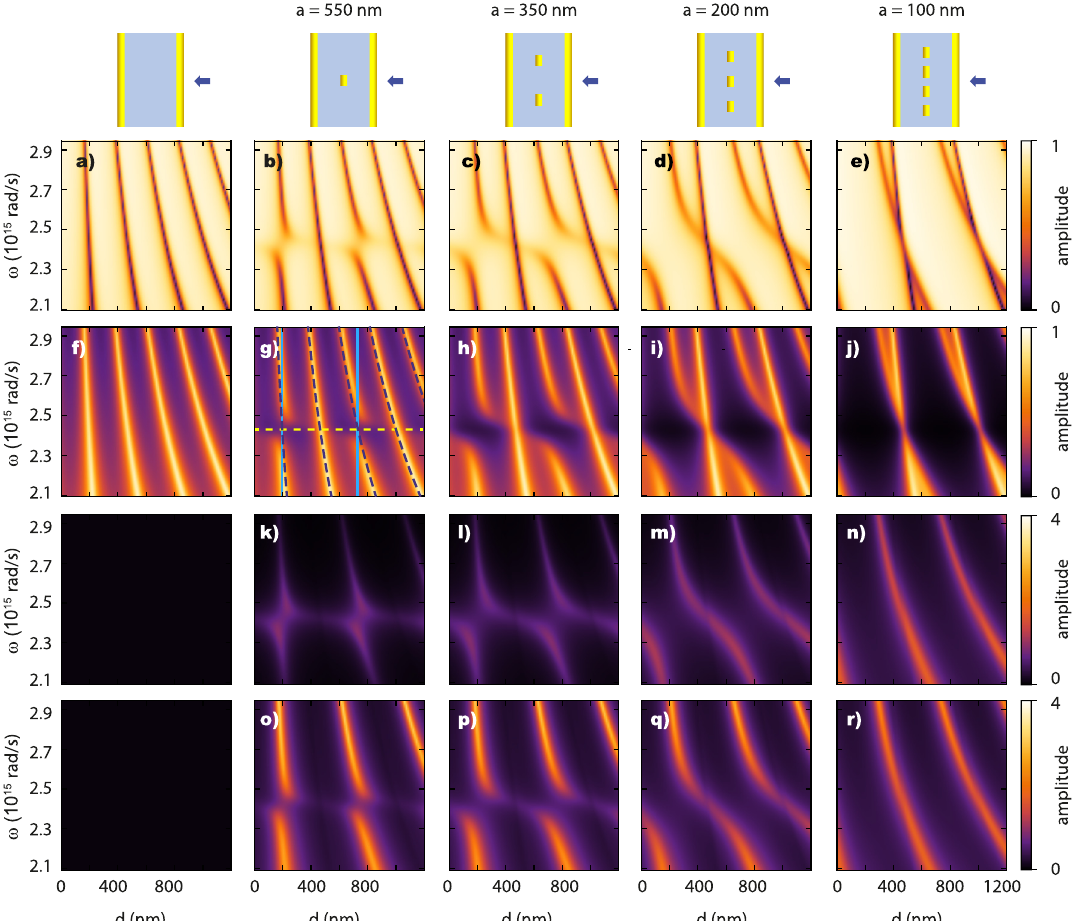
Figure 5: Calculated response of scattering nanoparticle arrays sandwiched between 20 nm Au mirrors, as a function of cavity length and frequency.NanoparticleparametersaretakenthesameasinFigure2.Columnsfromlefttoright:noarray,pitch550,350,200and100nm.The fi rsttworowsplotre fl ection(panelsa – e)andtransmissionamplitude(panelsf – j).Panel(g)isoverplotwithFabry – Pérotresonancelines(dark blue dashed) and a line indicating the scatterer resonance frequency ω 0 (yellow dashed). We take cross cuts (bright blue solid) through their points of intersection for the fi rst and third order mode to estimate the mode splitting due to the presence of the array (see also Figure 6). The third row (panels k – n) plots the dipole moment | p | of the array, referenced by the maximum dipole moment in the bare array. The bottom row (cid:15)(cid:15)(cid:15) (cid:15)(cid:15)(cid:15) of the bare array. The bottom two rows are both plot between 0 and 4 for (panels o – r) plots | p | referenced by the frequency dependent p ( ω )